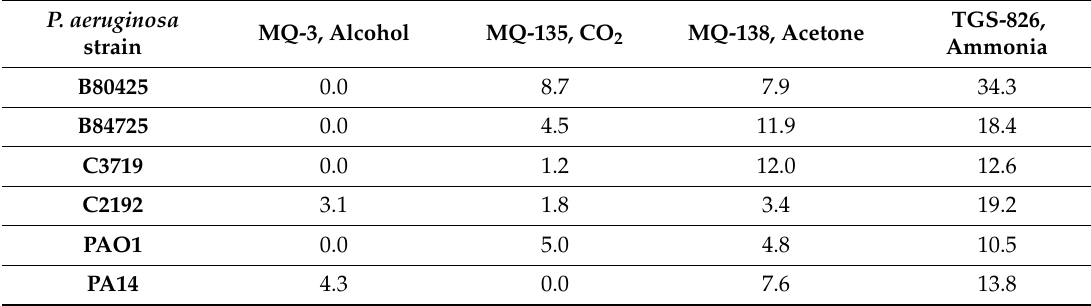
Table A2. Mean values of the P. aeruginosa solid samples at 5 mm.